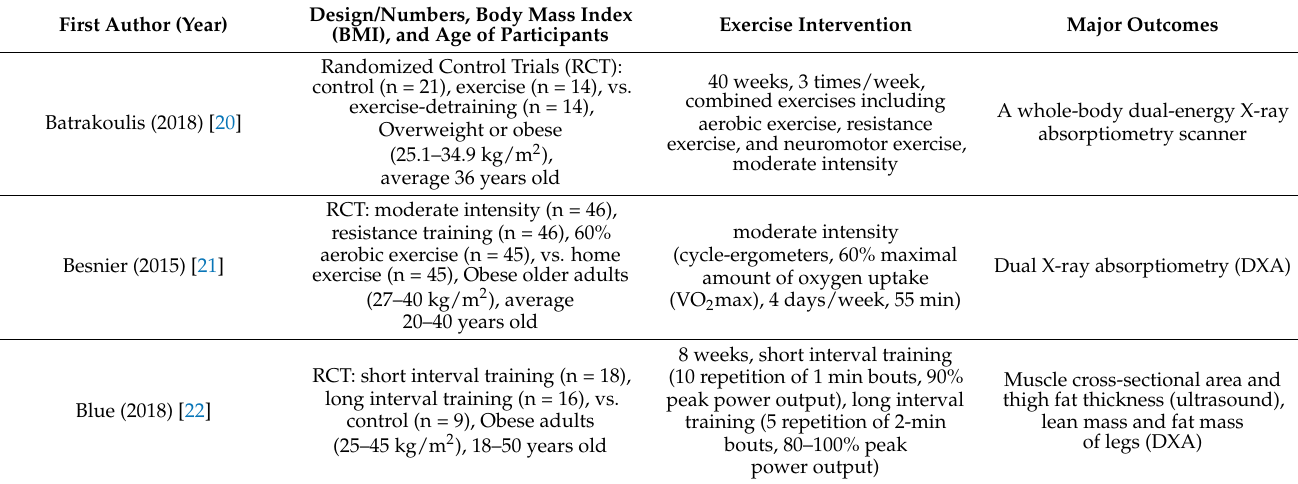
Figure 1. Selection process for the systematic review and meta-analysis. Table 1. Exercise intervention characteristics of selected